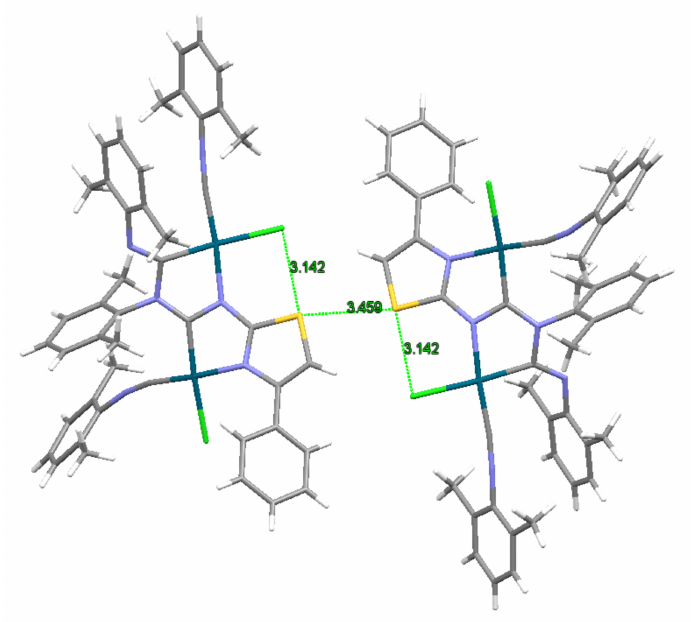
Figure 1. Intra-/intermolecular bifurcated chalcogen bonds in thiazole derived binuclear diaminocar- bene